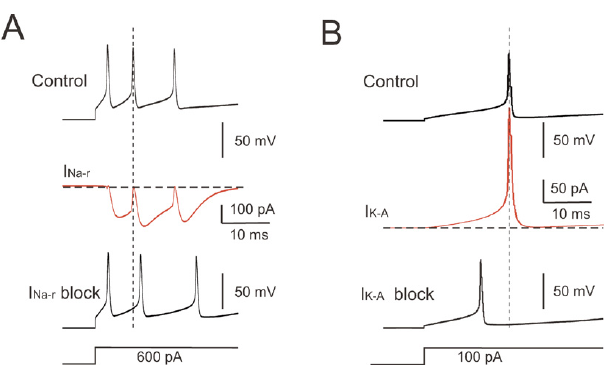
Figure 7. Ionic currents controlling response intensity and latency . ( A ) Effect of I Na-r on the first two spikes elicited by a depolarizing current step. The model was hyperpolarized to (cid:1) 70mV by tonic current injection and a step current injection of 600pA elicited an initial firing rate of 200Hz. I Na-r block (middle trace) increased the first ISI (2ms increase) reducing the initial firing rate to 142Hz. I Na-r did not affect the 1st spike latency but its activation after the 1st spike could accelerate membrane depolarization and generation of the 2nd spike. ( B ) The model was hyperpolarized to (cid:1) 70mV by tonic current injection and then injected with a step current of 100pA. The 1st spike latency was 18ms and was reduced by I KA blockage to 12ms. The lower traces show the stimulus protocols